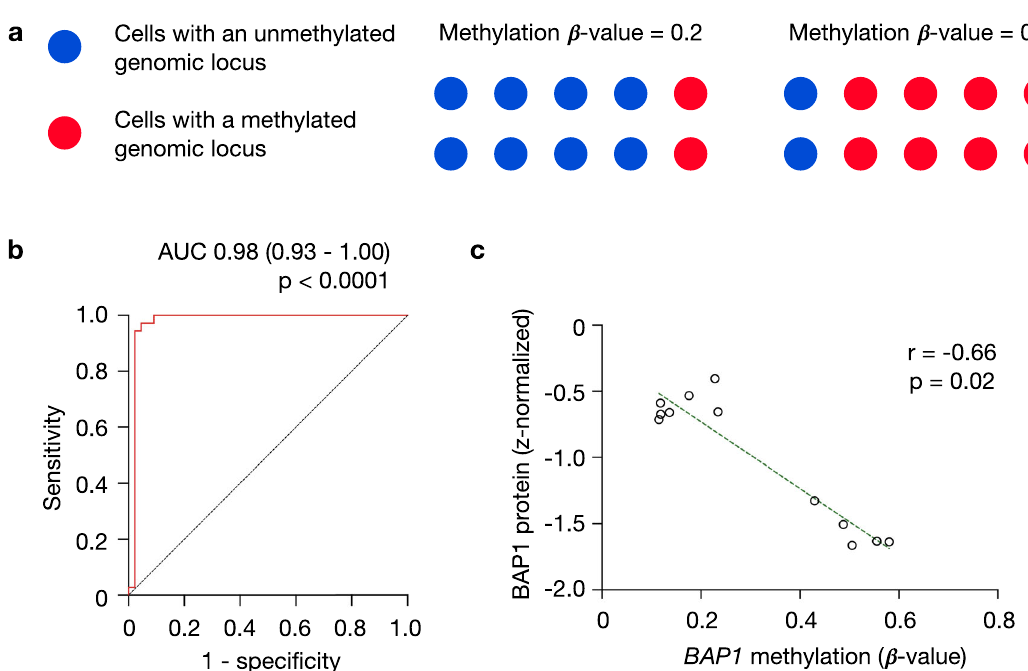
Fig. 1 BAP1 methylation — a surrogate for BAP1 genomic copy number and transcript levels. a β -methylation values are indicative of the fraction of cells that are methylated within the specimen at that speci fi c locus. b ROC curve for the association between BAP1 methylation (derived from In fi nium HumanMethylation450K BeadChip arrays) and BAP1 genomic copy loss (data accessed from cbioportal 15,16 ). The reference line for random prediction is shown (dotted). AUC, area under the ROC curve, with 95% con fi dence intervals. c BAP1 protein levels plotted as a function of BAP1 β -methylation values among 12 primary UM tumors from the TCGA-UM cohorts, with reported Spearman ’ s rank correlation coef fi cient. Dotted line represents regression